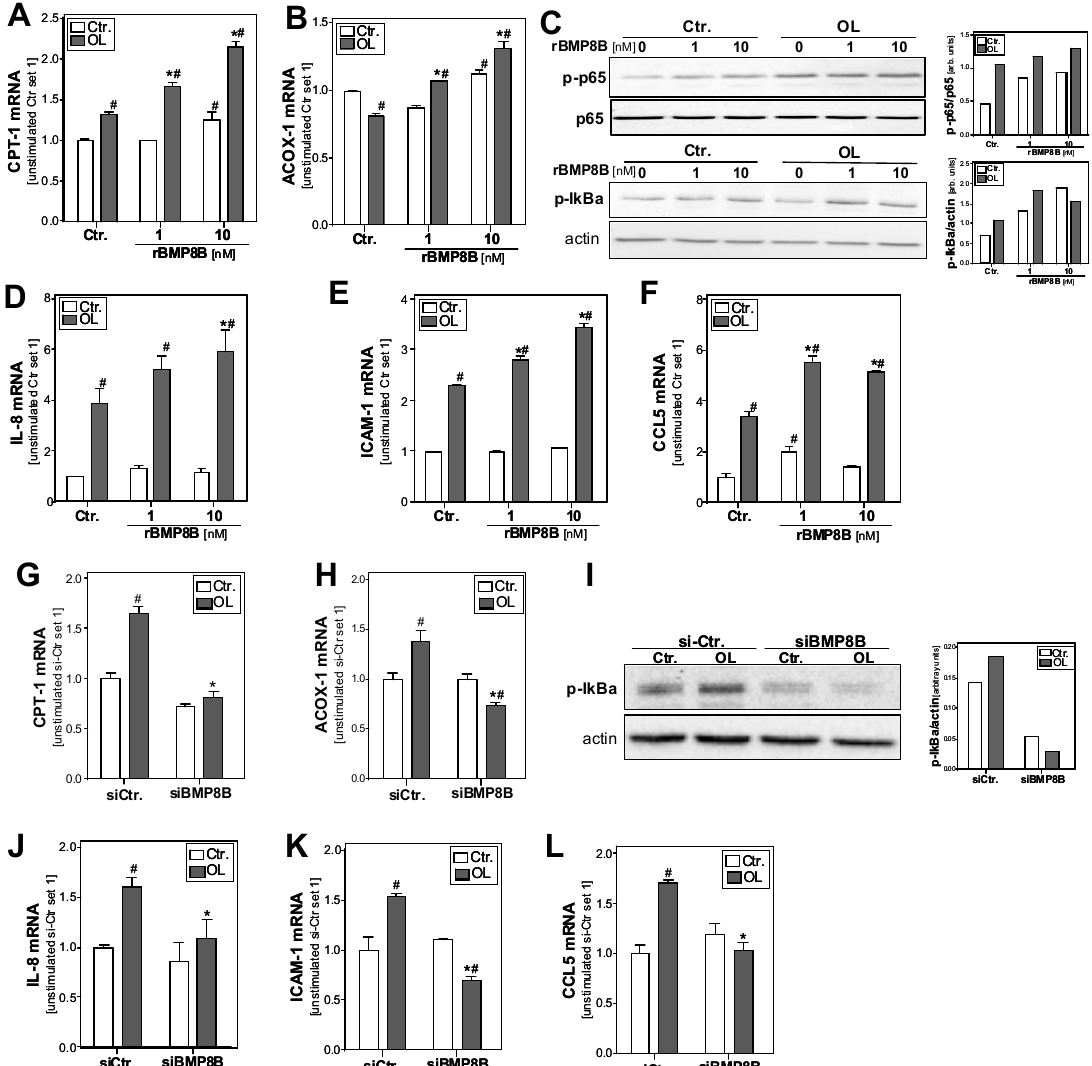
Figure 4. E ff ect of BMP8B (depletion) on hepatocellular oxidative stress and inflammation. ( A – F ): PHH were incubated with the fatty acid OL (0.4 mM) for 24 h in the presence or absence of recombinant rBMP8B. ( G – L ): BMP8B mRNA expression was depleted in HepG2 hepatoma cells by transfection with si-RNA (si-BMP8B); control cells were transfected with control-siRNA (si-Ctr). Subsequently, the cells were incubated with or without 0.4 mM OL for additional 24 h. Cellular mRNA levels of CPT-1 ( A , G ) and ACOX-1 ( B , H ) analyzed by quantitative RT-PCR. ( C , I ) Western blot analysis of p-p65 and p-I κ B α protein levels; unphosphorylated p65 and actin served as control for loading adjustment. The right panels depict the densitometric analysis. Cellular mRNA levels of ( D , J ) IL-8, ( E , K ) ICAM-1, and ( F , L ) CCL5 analyzed by quantitative RT-PCR. ( A – F ): * p < 0.05 compared with the corresponding condition without BMP8B stimulation; # p < 0.05 compared with the corresponding condition without OL stimulation; ( G – L ): * p < 0.05 compared with si-Ctr-transfected cells; # p < 0.05 compared with cells without OL stimulation; two-way